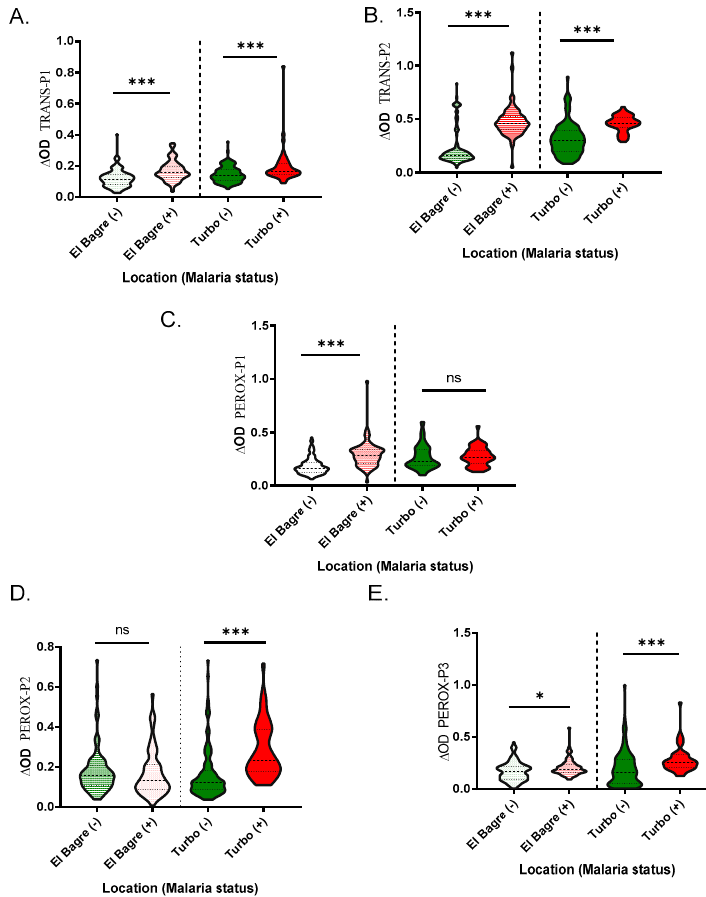
Figure 4. Schematic representation of the IgG antibody levels against the An. albimanus peptides, TRANS-P1 ( A ), TRANS-P2 ( B ), PEROX-P1 ( C ), PEROX-P2 ( D ), and PEROX-P3 ( E ). Pairwise significance was tested with Mann-Whitney test with significance represented by stars ( p < 0.05 ( * = 0.01 to 0.05, ** = 0.001 to 0.01, and *** = 0.0001 to 0.001). ns denotes “not significant.”